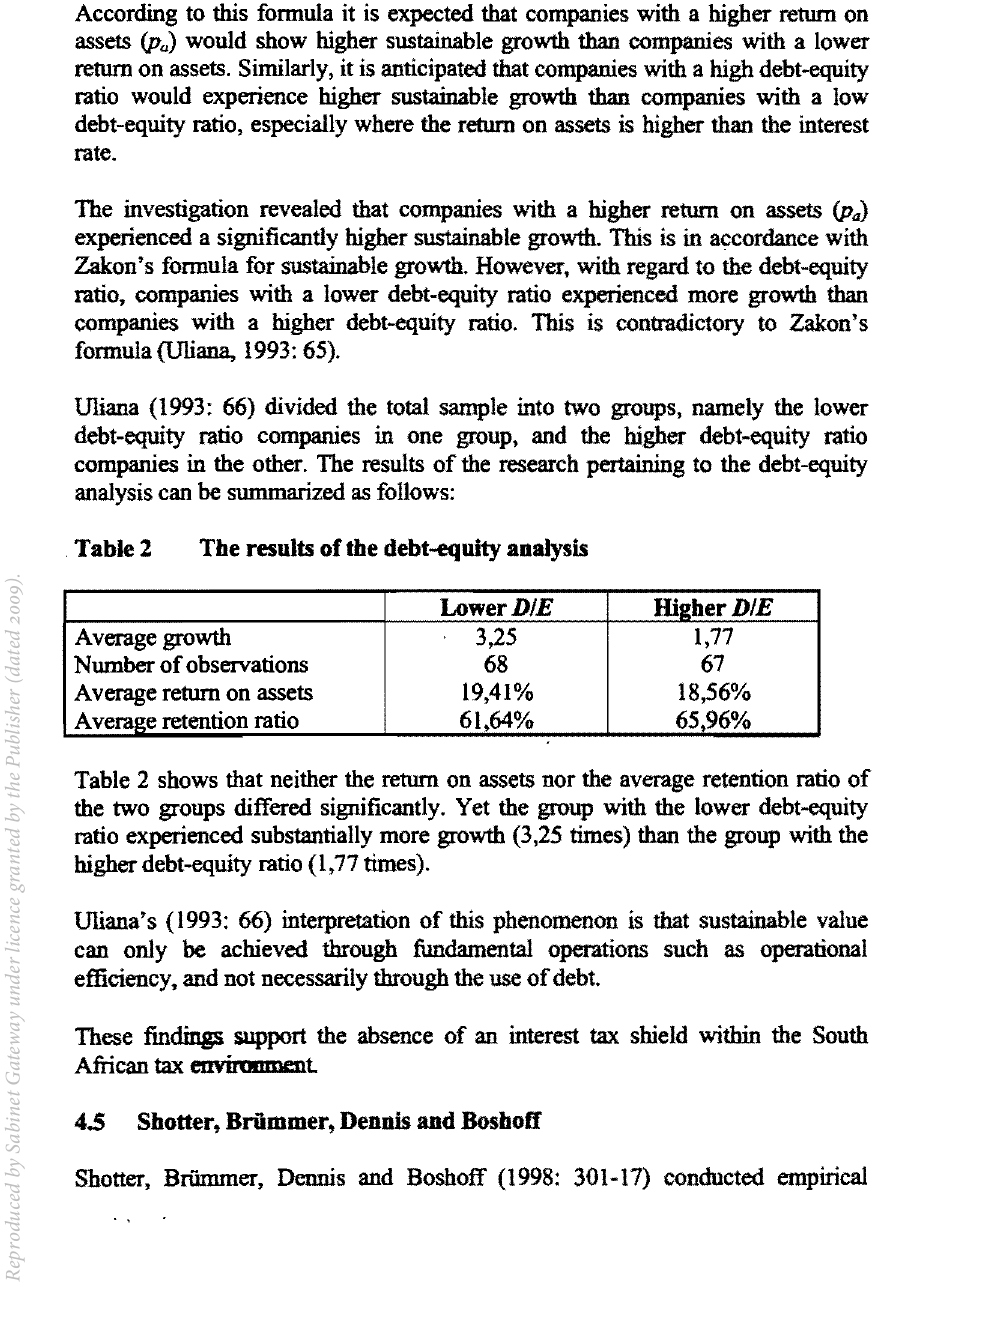
Tbe results oftbe debt-equity analysis Lower DIE Higher DIE Average